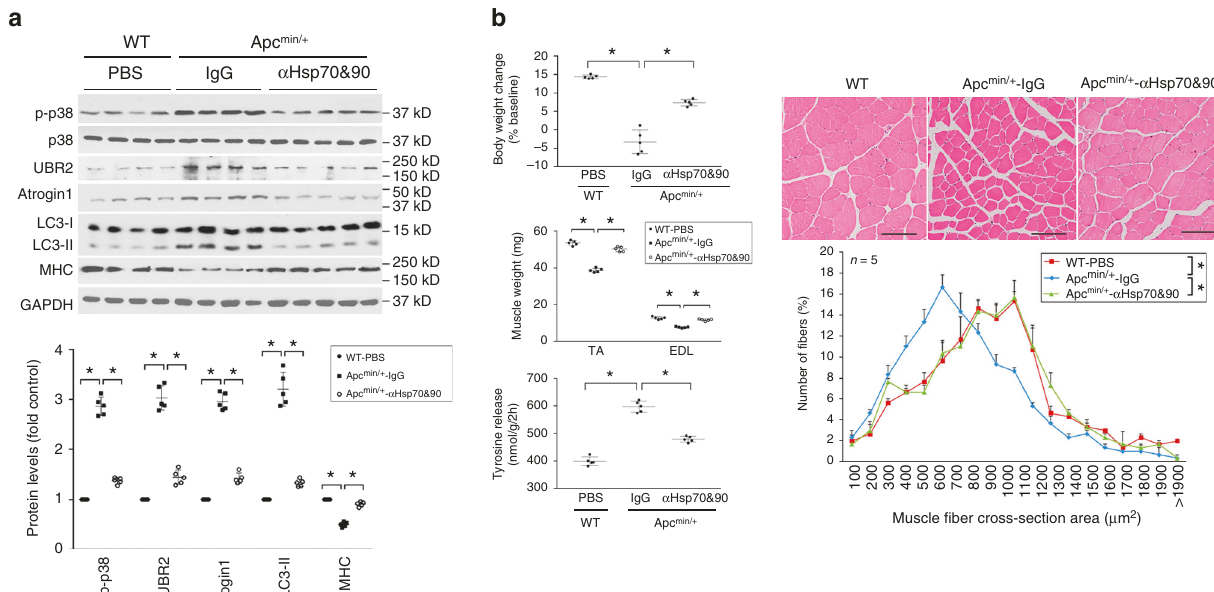
Fig. 3 Elevated circulating Hsp70 and Hsp90 are critical to the development of muscle wasting in Apc min/+ mice. a Neutralizing antibodies of Hsp70 and Hsp90 block the activation of catabolic pathways in the muscle in Apc min/+ mice. Pre-cachectic Apc min/+ mice (16 weeks of age) were administered with neutralizing antibodies against Hsp70 and Hsp90 or pre-immune IgG subcutaneously via osmotic pumps at 3 μ g/day each for 4 weeks. Wild-type mice in the same background (C57BL/6) were administered PBS for comparison. At 20 weeks of age the mice were killed and analyzed for activity of the catabolic pathways in TA. b Neutralizing antibodies of Hsp70 and Hsp90 attenuated muscle wasting in Apc min/+ mice. Mice derived from a were further evaluated for muscle wasting. Body weight baseline was at 12 weeks of age. Scale bar , 100 μ m. Data ( n = 5) were analyzed by ANOVA or χ 2 analysis (for CSA). * denotes a difference ( P < through their direct action on muscle cells without the need for new protein synthesis by muscle cells or input from immune cells.